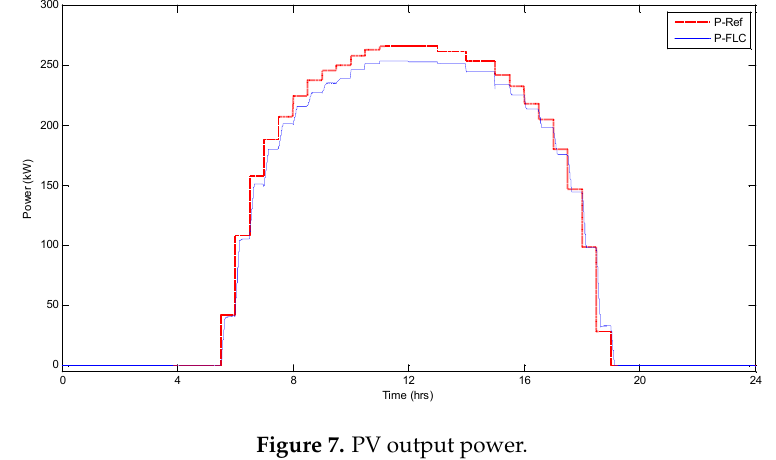
Figure 7. PV output power.